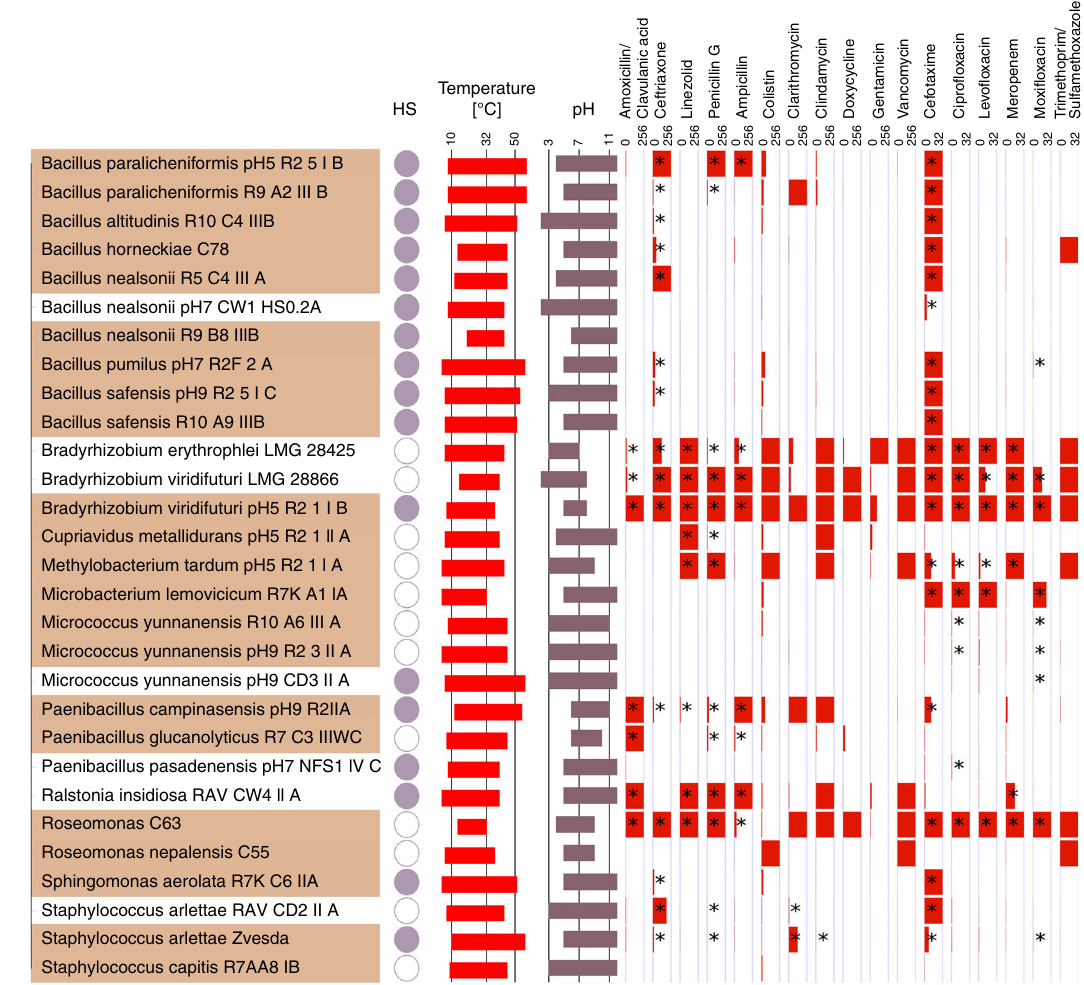
Fig. 6 Resistances of selected microorganisms from ISS. ISS isolates (highlighted in brownish color) were compared with closely related isolates from ground controls (clean rooms, culture collections; white). Datasets re fl ect resistances to heat shock ( fi lled circle: heat-shock resistance), temperature range of growth (red), pH range of growth (gray) and resistance toward antibiotics (dark red). Antibiotics were applied in maximal concentrations of 256 and 32 µ g/ml, as indicated. Bars re fl ect the minimal inhibitory concentrations as determined experimentally. A full red bar indicates resistance against the maximal concentration tested. Asterisks indicate when an isolate was deemed resistant against a certain antibiotic according to the EUCAST guidelines for PK/PD (non-species related) and Staphylococcus spp. breakpoints. Partial information on some of the isolates is already available